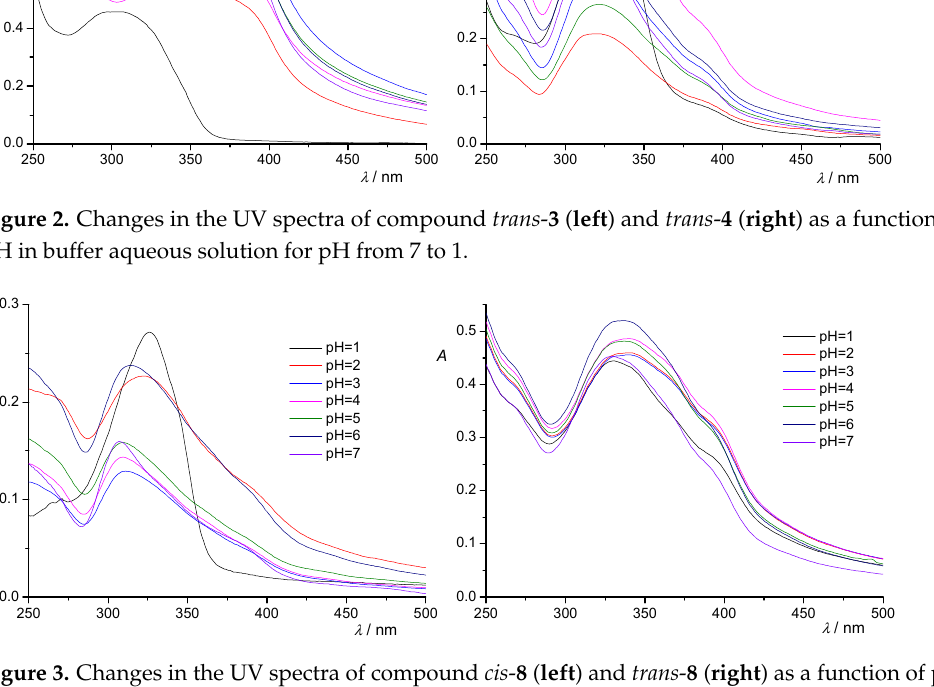
Figure 3. Changes in the UV spectra of compound cis - 8 ( left ) and trans - 8 ( right ) as a function of pH in buffer aqueous solution for pH from 7 to 1.